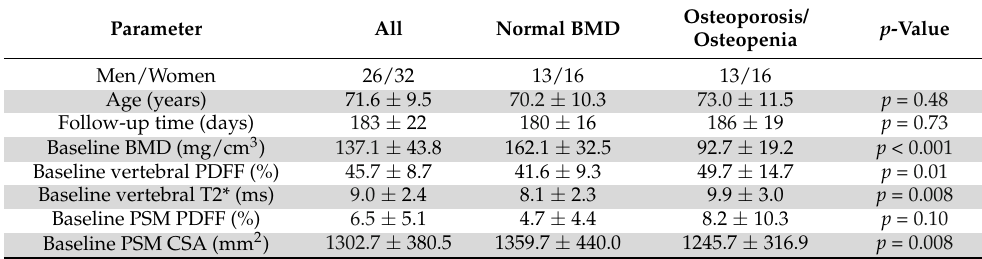
Table 1. Subject demographics and baseline values.